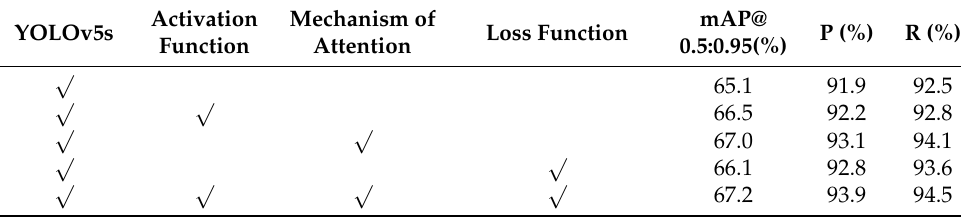
Table 6. Comparison table of ablation experiments.